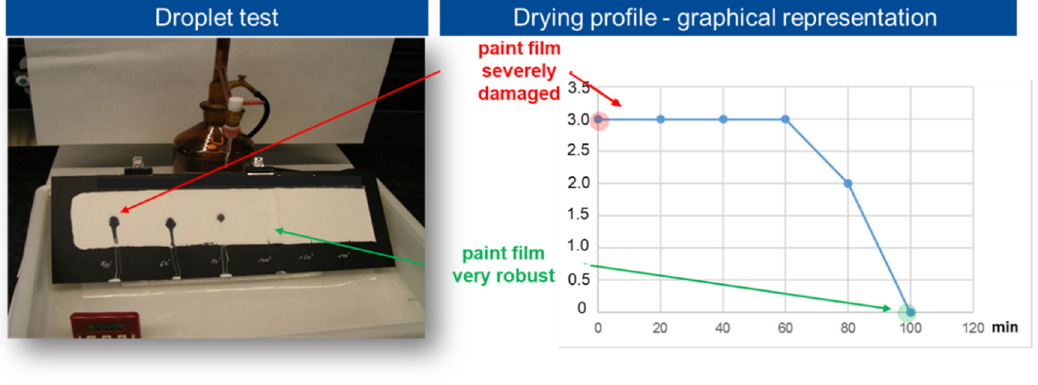
Figure A1. Setup for early rain resistance testing for façade paints.